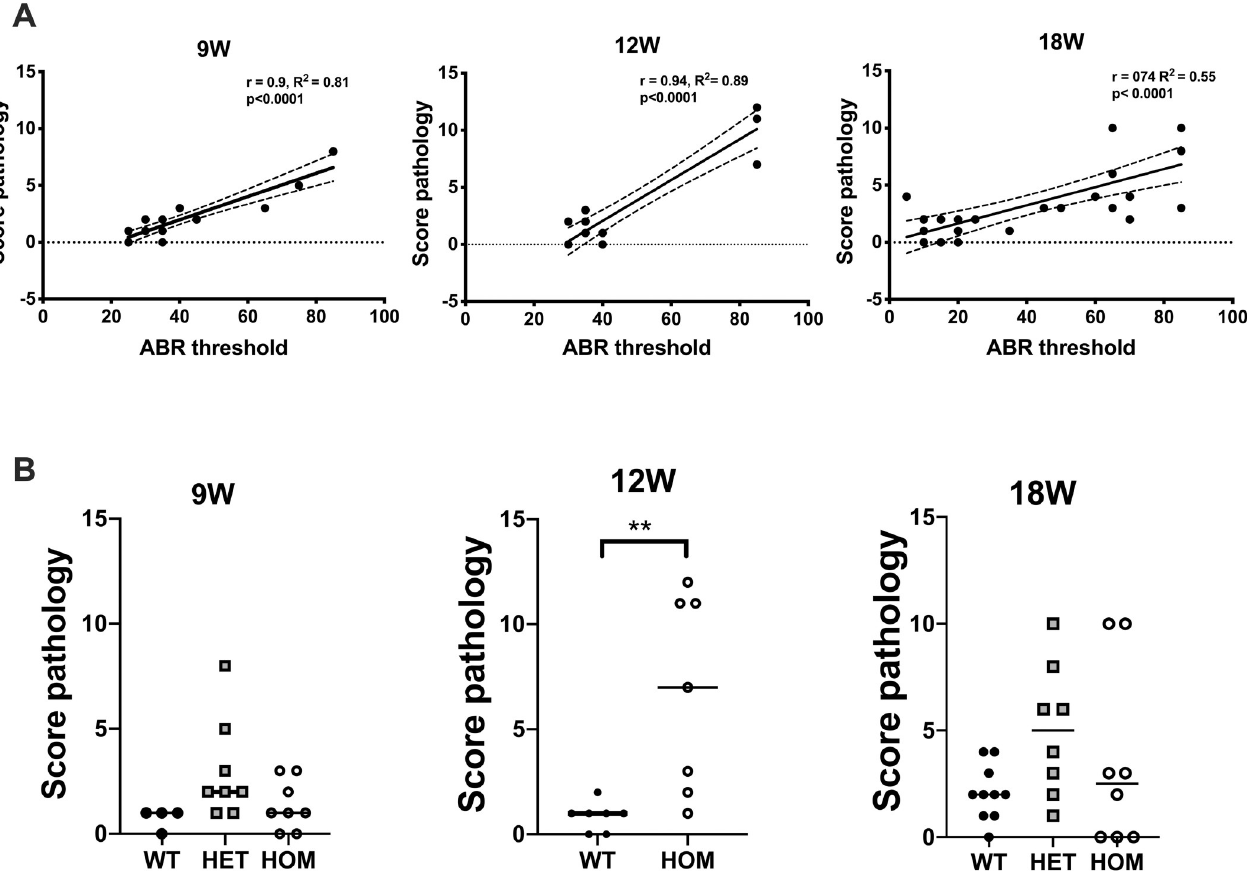
Fig 5. ABR thresholds increase with the score pathology. (A) Correlations between ABR thresholds and score pathologies. Mice ears with a higher ABR thresholds are associated with higher score pathology. Growth slope was calculated using a linear regression. Dashed lines depict the 95% confidence interval. (B) STAT1-KO mice at 12 weeks of age exhibit higher score pathology than wild type (WT) mice. Each data point represents the sum of the pathology score in one ear. Mann-Whitney test was used to compare two genotype groups. Kruskal Wallis test followed by Dunn’s multiple comparison test was used to compare three groups. �� P < 0.01. HET, heterozygous; HOM